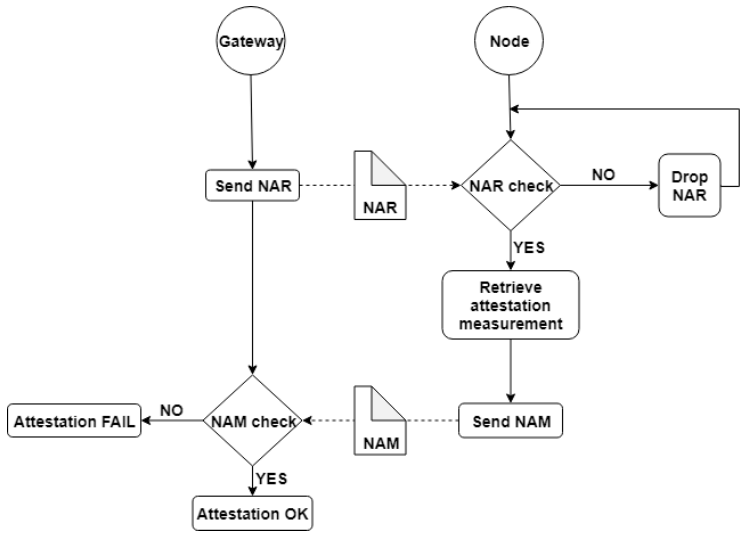
Figure 6. The architecture of the Remote Node Attestation Module.